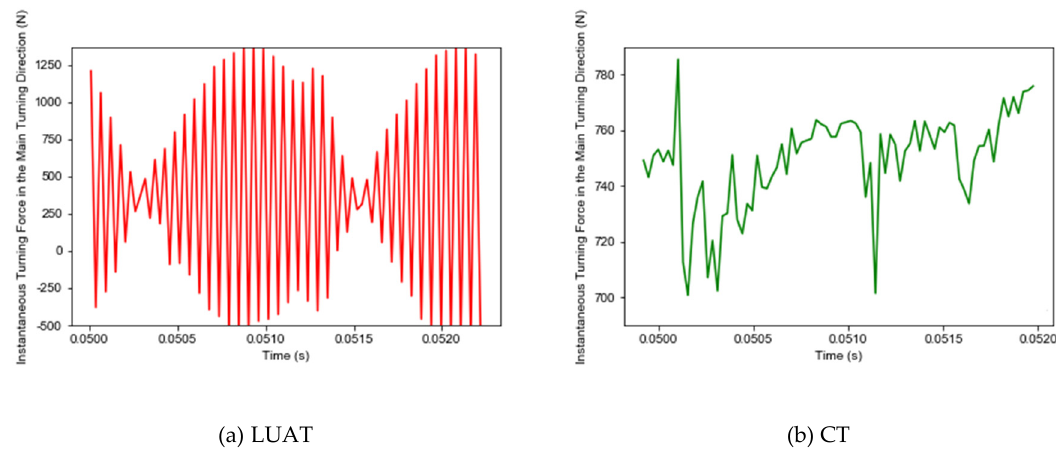
Figure 10. Instantaneous cutting force in main turning direction. ( a ) LUAT; ( b ) CT.